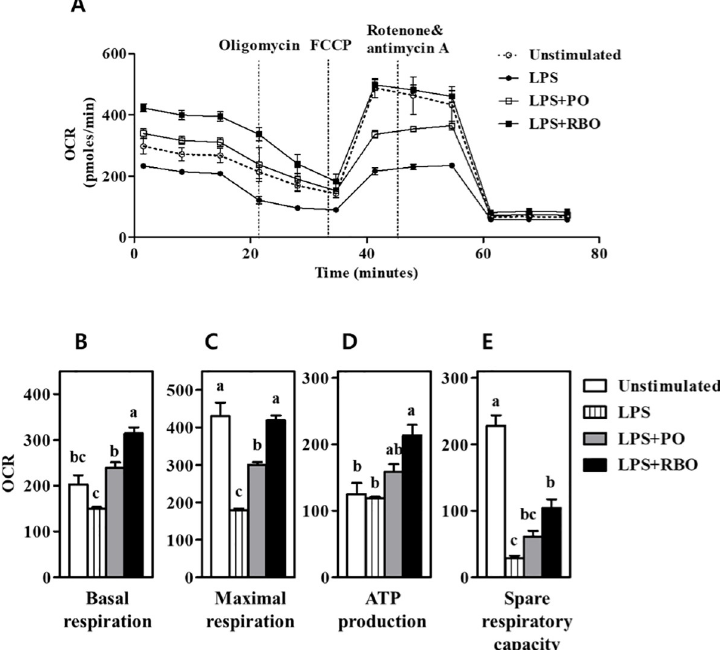
Fig 5. Quantification of mitochondrial respiration, as assessed by the oxygen consumption rate (OCR) determined with a SeahorseTM extracellular flux analyzer in RAW 264.7 macrophages. (A) Real-time OCR quantification of activated and/or oil-treated cells, with appropriate drugs to control mitochondrial respiration, resulting in analysis of (B) basal respiration, (C) maximal respiration, (D) ATP production, and (E) spare respiratory capacity. Values with different letters are statistically significant at p < 0.05 within the panel. (PO, palm oil; RBO, rice bran oil).